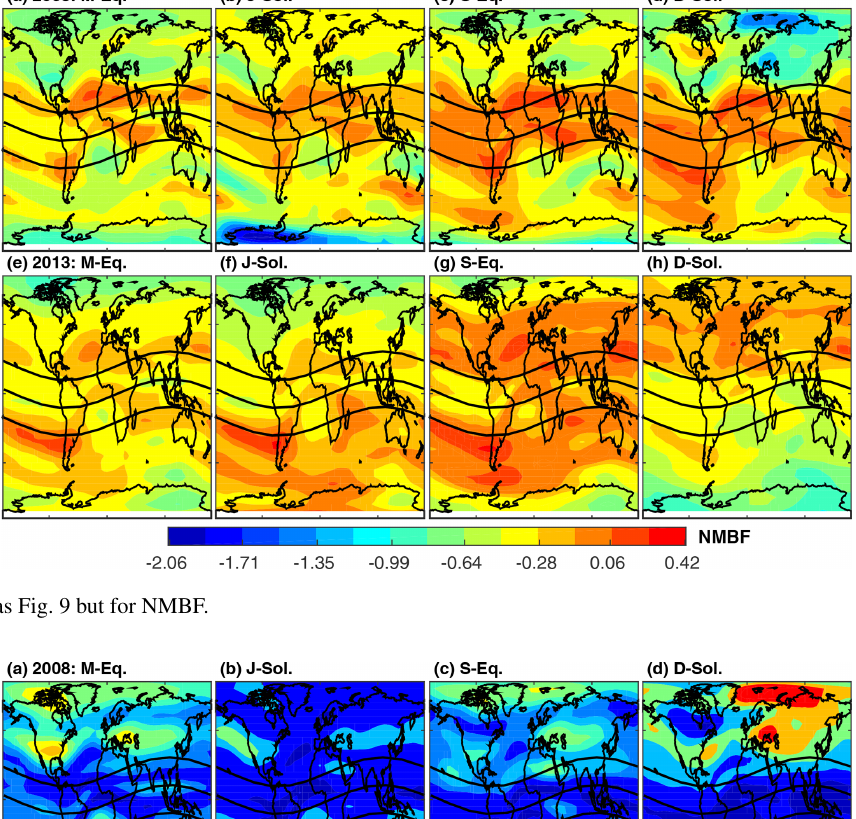
Figure 10. The same as Fig. 9 but for NMBF.